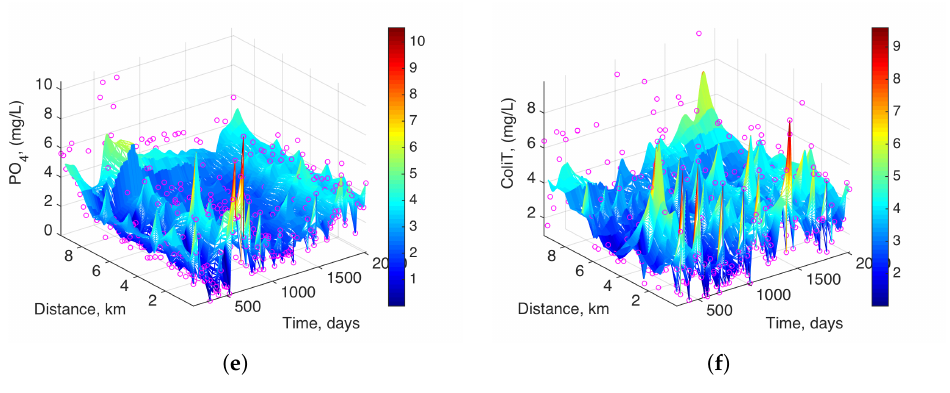
Figure 5. Results of Delaunay and k NN Interpolation methods: ( a ) NH 3 with Delaunay linear; ( b ) NH 3 with Delaunay nearest; ( c ) NH 3 with k NN; ( d ) PO 4 with Delaunay linear; ( e ) PO 4 with k NN; and ( f ) ColiT with k NN.